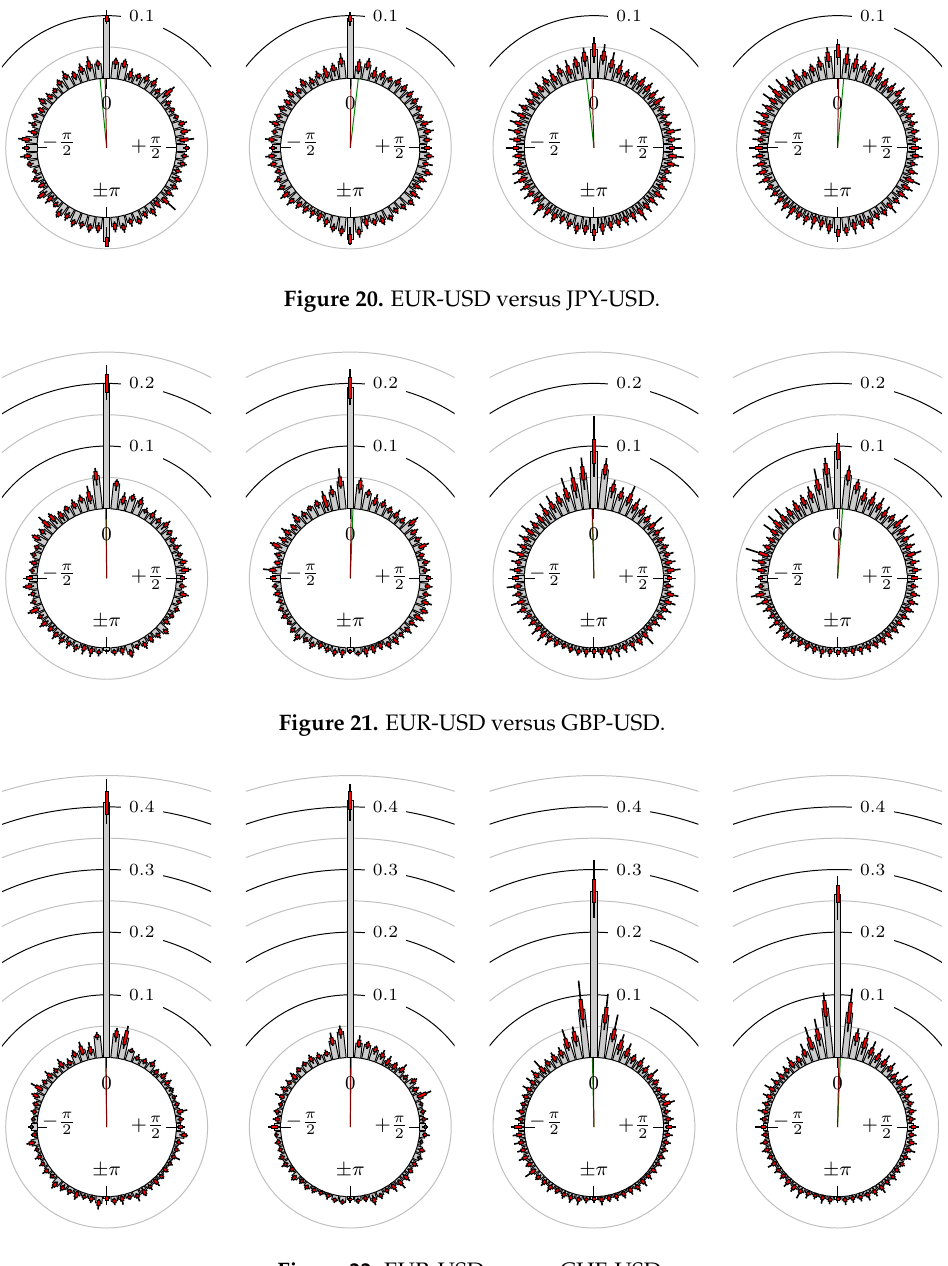
Figure 22. EUR-USD versus